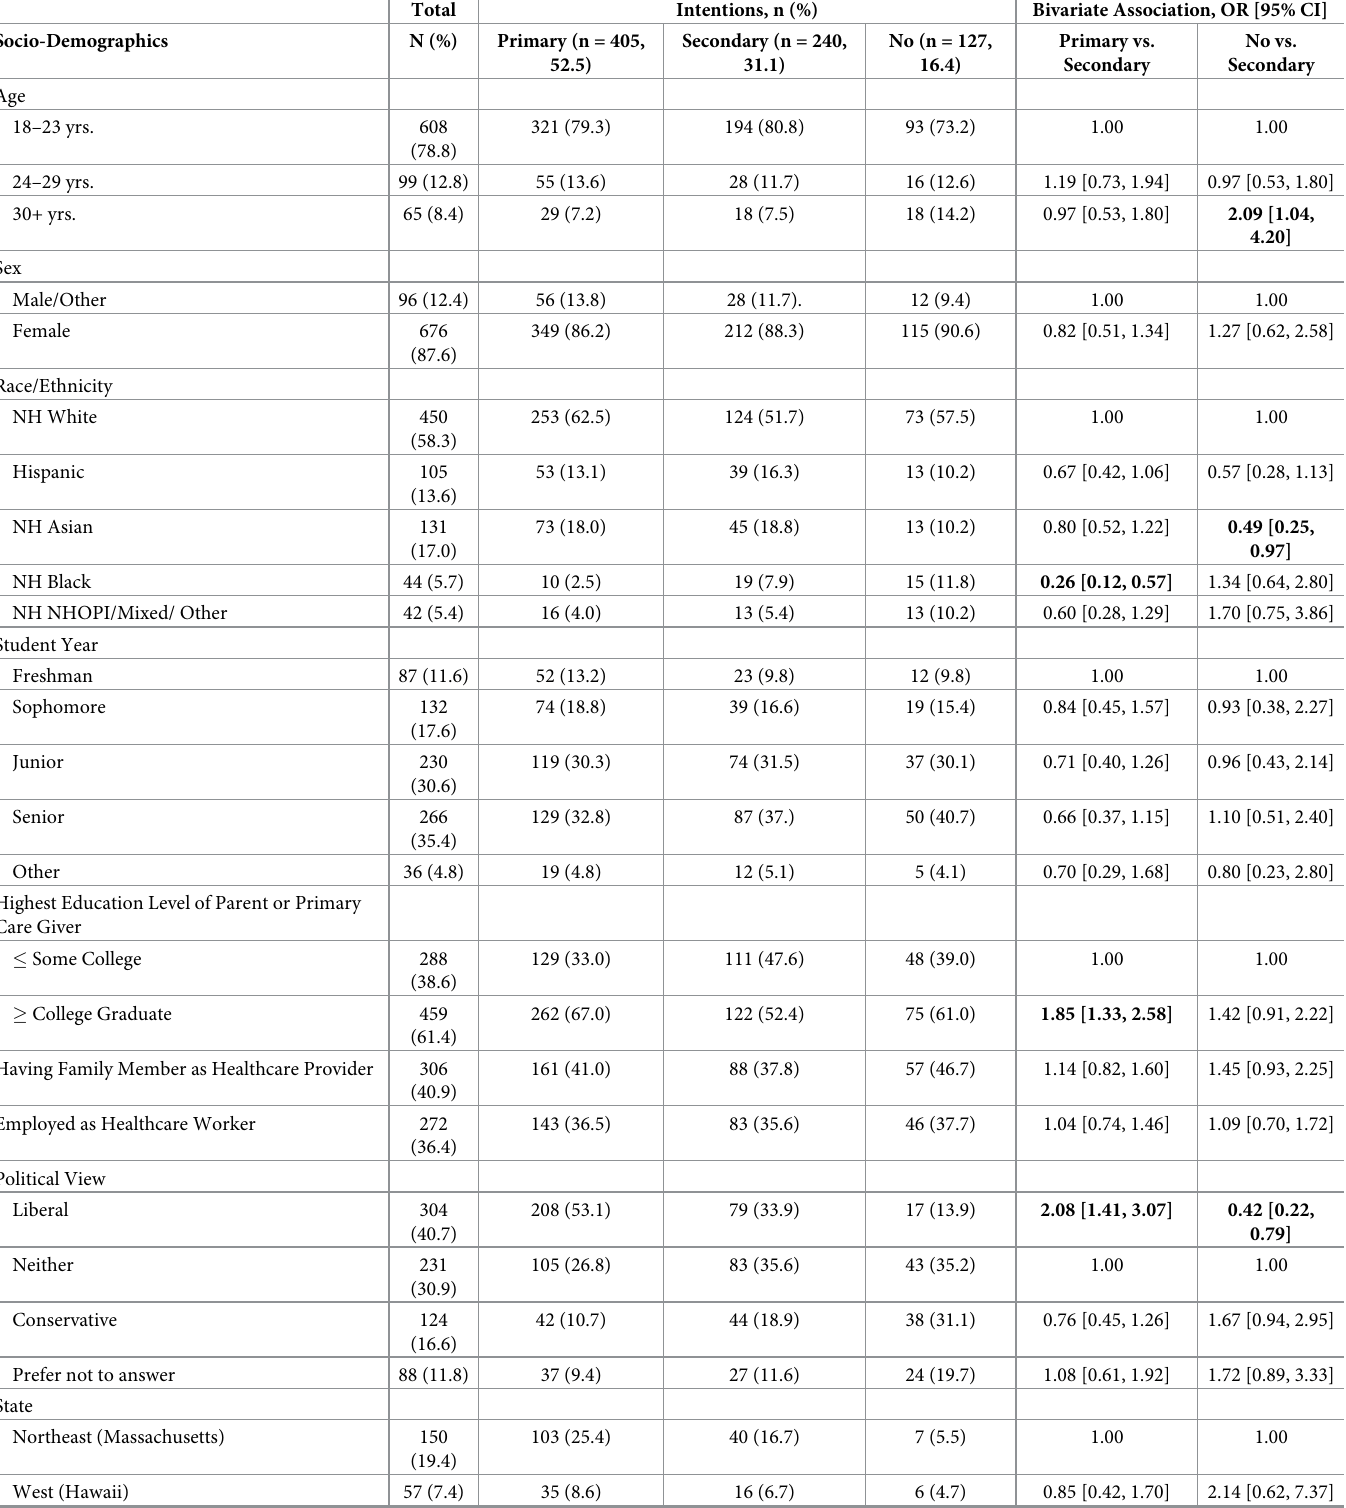
Table 1. Socio-demographics, vaccine intentions, and bivariate association between socio-demographics and COVID-19 vaccine intention. Total Intentions, n